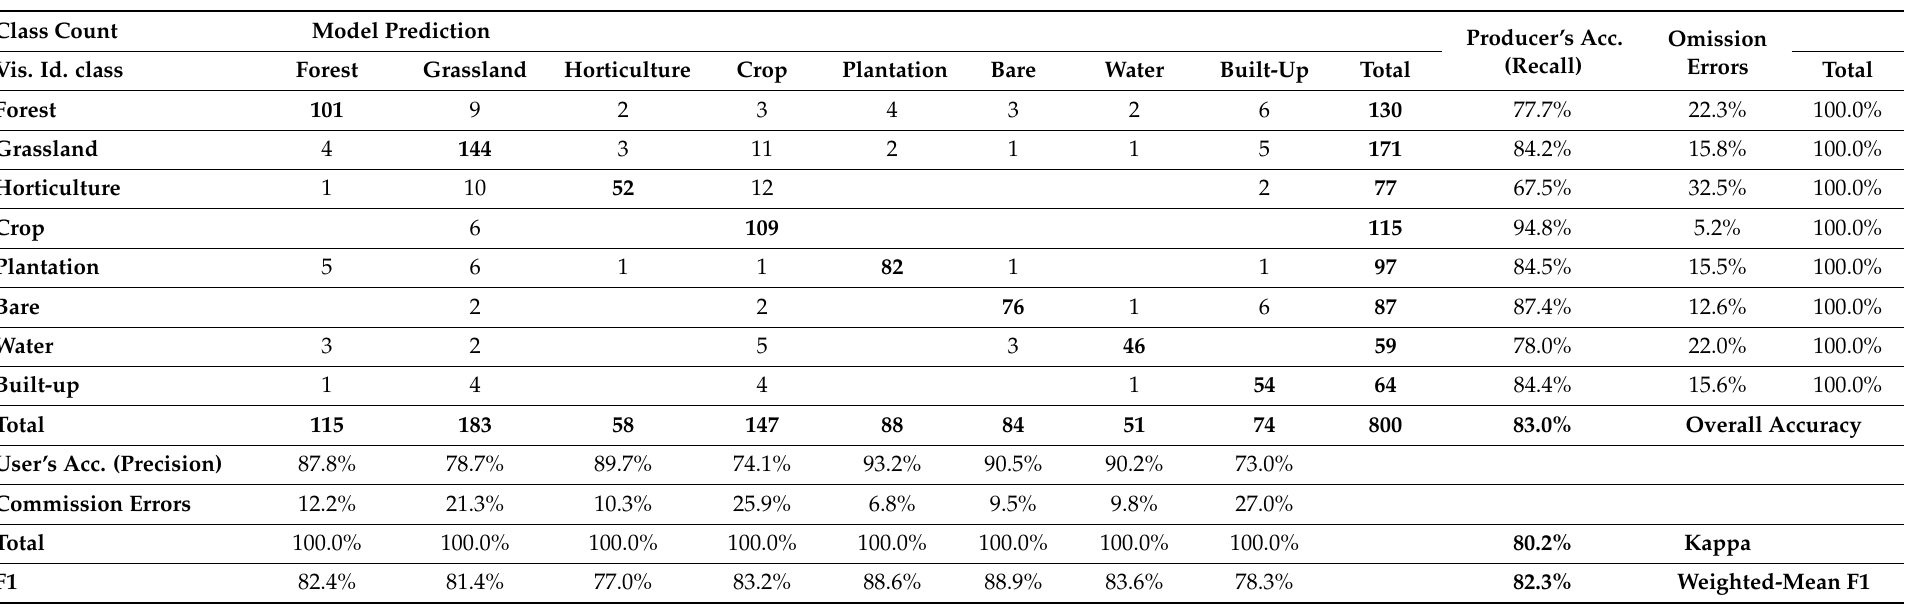
Table 3. Confusion matrix comparing visually identified class (rows) to model prediction (columns). Matching class counts (diagonal), totals and primary metrics are in